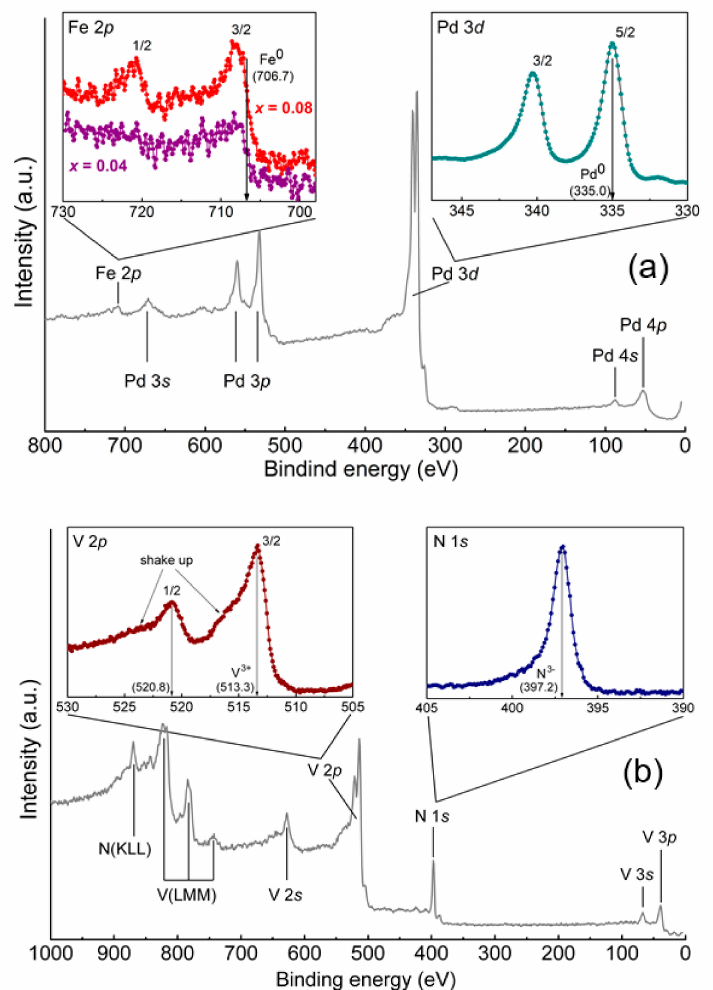
Figure 2. XPS (X-ray photoelectron spectroscopy) spectra of the top layer: ( a ) after depositions of the Pd 1 − x Fe x alloy layer, where the overview spectrum is shown for the Pd 0.92 Fe 0.08 layer; and ( b ) after deposition of the VN-layer, where callouts show high-resolution spectra in the particular ranges of binding energies of the constituent